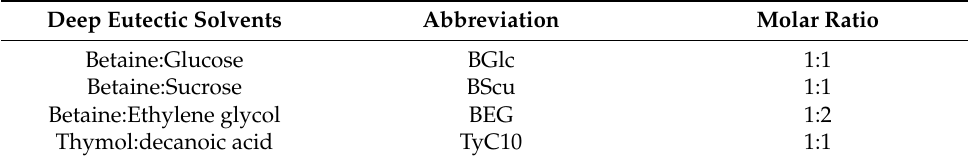
Table 3. Used DES in this